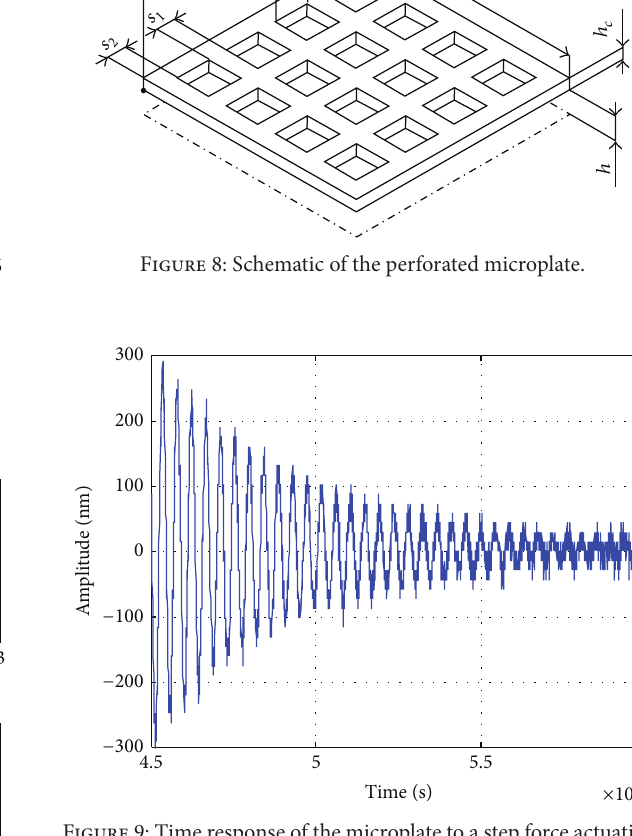
Figure 9: Time response of the microplate to a step force